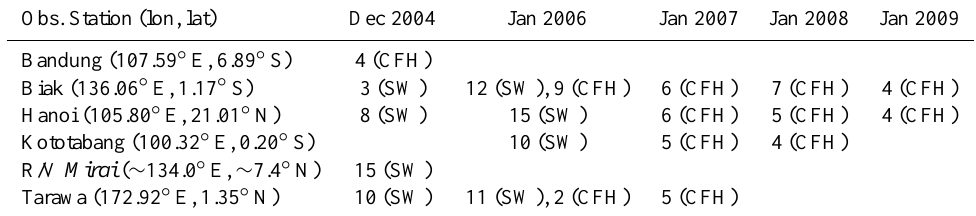
Table 1. Number of water vapor soundings during SOWER campaigns in December 2004, January 2006, January 2007, January 2008, and January 2009. Water vapor was measured using the Snow White (SW) hygrometer or the Cryogenic Frostpoint Hygrometer